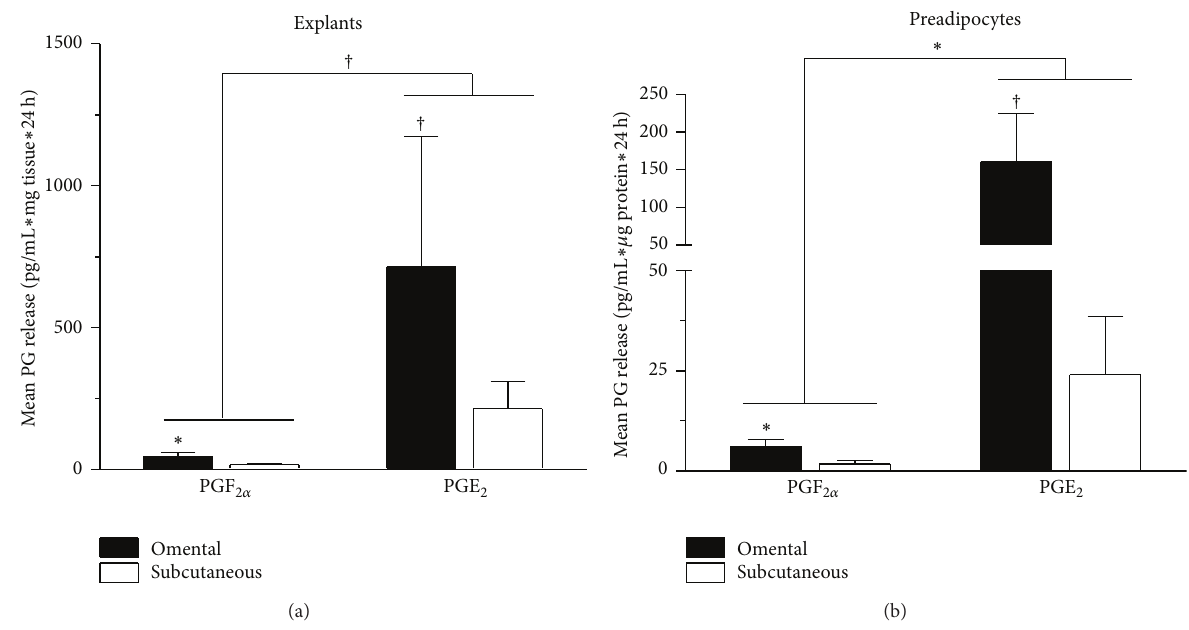
Figure 1: Basal release of PGE 2 and PGF 2𝛼 by subcutaneous and omental (a) adipose tissue explants ( 𝑛 = 8 ) or (b) primary preadipocyte cultures (OM: 𝑛 = 11 and SC: 𝑛 = 9 ). PGE 2 and PGF 2𝛼 release by adipose tissue explants was expressed as pg/mL ∗ mg tissue ∗ 24 h and PGE 2 and PGF 2𝛼 release by cultured primary preadipocytes was expressed as pg/mL ∗𝜇 g protein ∗ 24h. Results are expressed as mean ± SEM. † 𝑃 < 0.10 ; ∗ 𝑃 ≤ 0.05